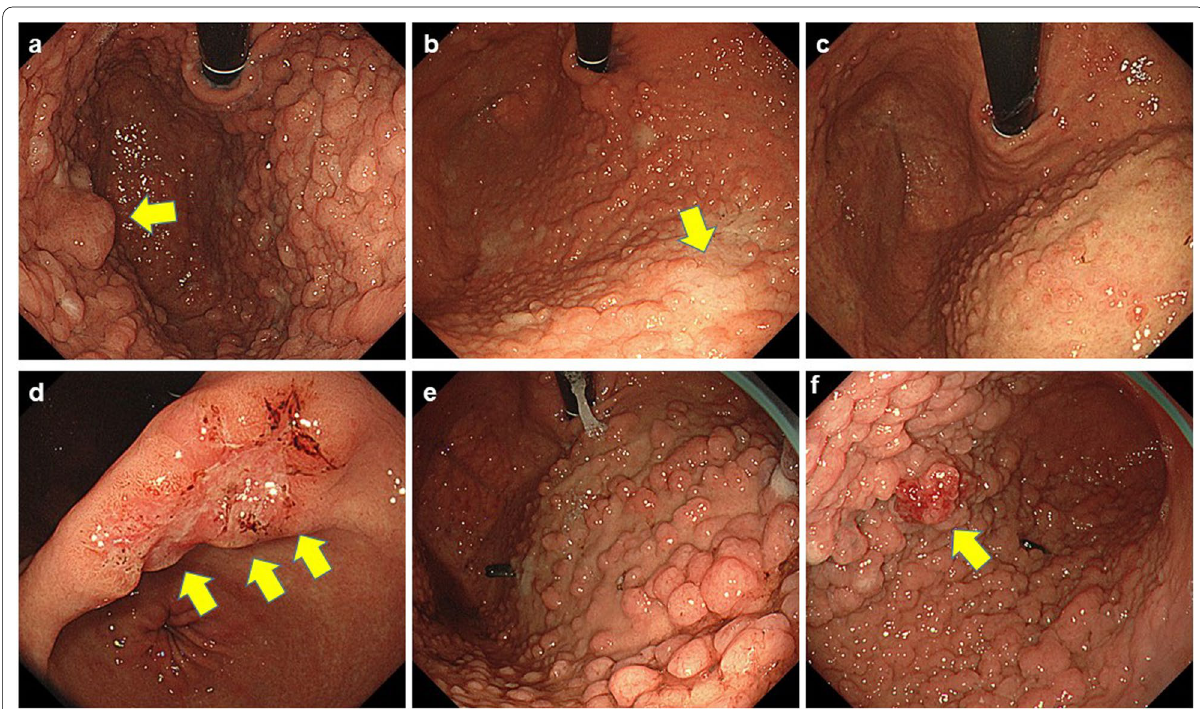
Fig. 1 Esophagogastroduodenoscopy. a Case 1; b Case 2, cancer-suspected lesion (arrow); c Case 3; d adenocarcinoma in Case 3 (arrow); e Case 4; f raised lesions in the gastric body in Case 4